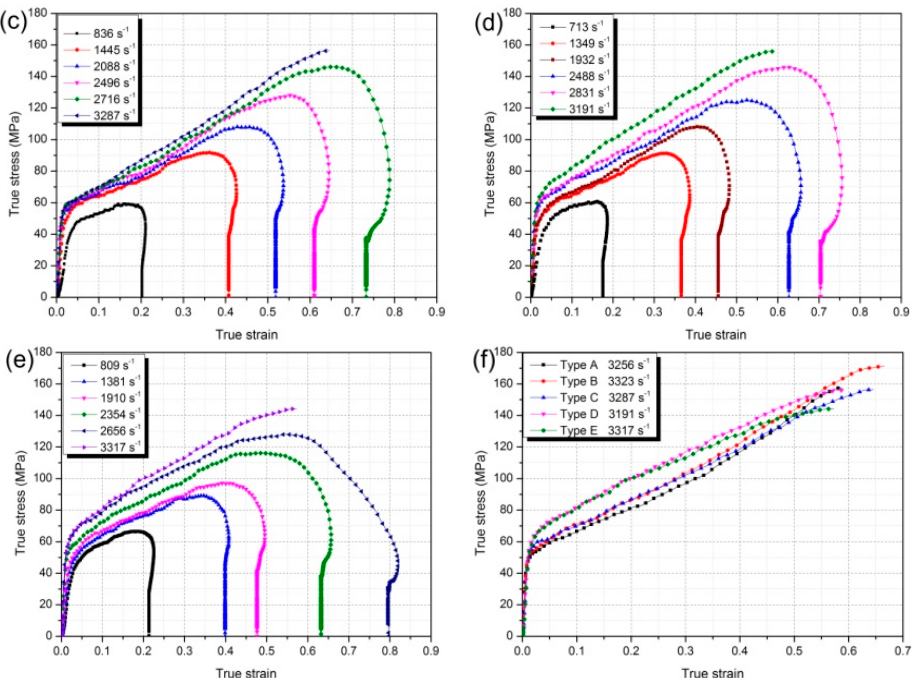
Figure 6. True stress-strain curves of ( a ) type A; ( b ) type B; ( c ) type C; ( d ) type D; ( e ) type E composites at different strain rates, and ( f ) the comparison of the five materials’ mechanical properties at the same strain rate of about 3200 s − 1 . Table 3. Mechanical parameters of PTFE/Al/TiH 2 composites under dynamic compression loading.